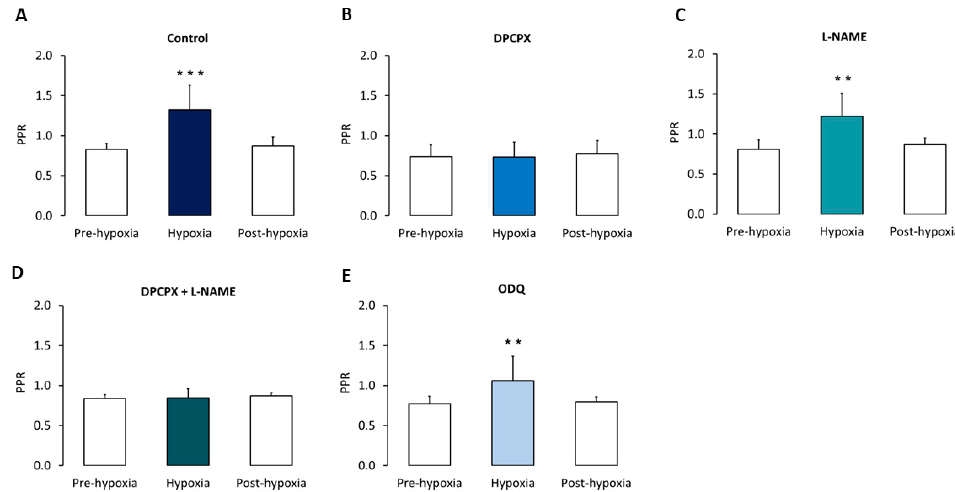
Figure 4. Paired-pulse ratio changes induced by hypoxia. ( A – E ) Comparison of the mean ( ± SD) paired-pulse ratio (PPR) of synaptic peak amplitudes (average of six consecutive responses to the second pulse (R2) divided by the average of six consecutive responses to the first one (R1)) recorded during the last minute before hypoxia onset (pre-hypoxia), during the minute corresponding to the maximal hypoxia-induced depressive effect of the response evoked by the first pulse (hypoxia), and during min 20 after re-oxygenation onset (post-hypoxia), in: ( A ) control conditions ( n = 5); ( B ) after pre-treatment with the A 1 receptors antagonist DPCPX (50 nM; n = 4); ( C ) after pre-treatment with the NO synthase inhibitor L-NAME (2 mM; n = 5); ( D ) after pre-treatment with both DPCPX (50 nM) and L-NAME (2 mM)( n = 4); ( E ), after pre-treatment with the NO-sensitive GC inhibitor ODQ (100 µM; n = 5). *** p < 0.005, ** p < 0.01.